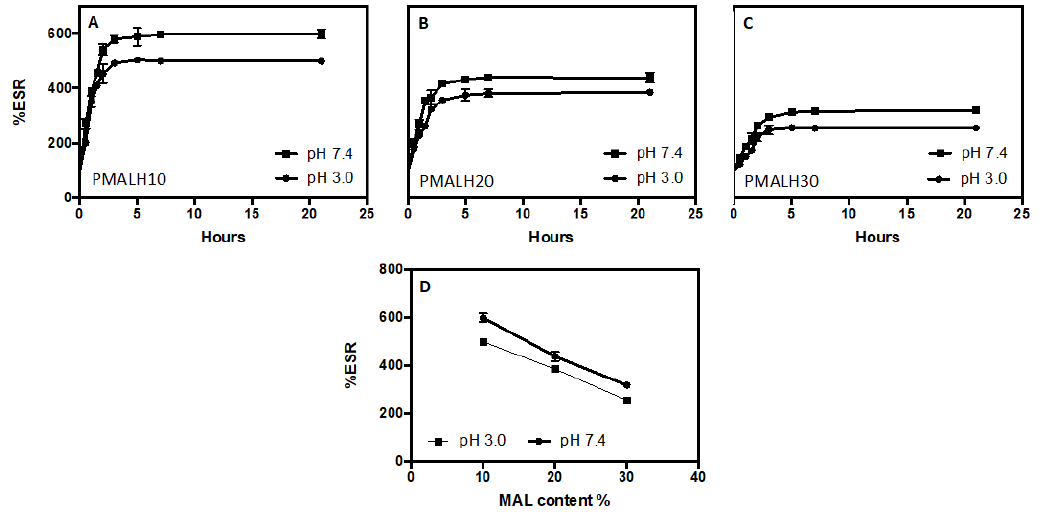
Figure 3. Swelling index of ( a ) PMALH10, ( b ) PMALH20, and ( c ) PMALH30 in two different buffers (pH 3.0, 7.4) with respect to time. ( d ) %ESR of PMALH10, PMALH20, and PMALH30 at pH 7.4 and 3.0 with respect to time.